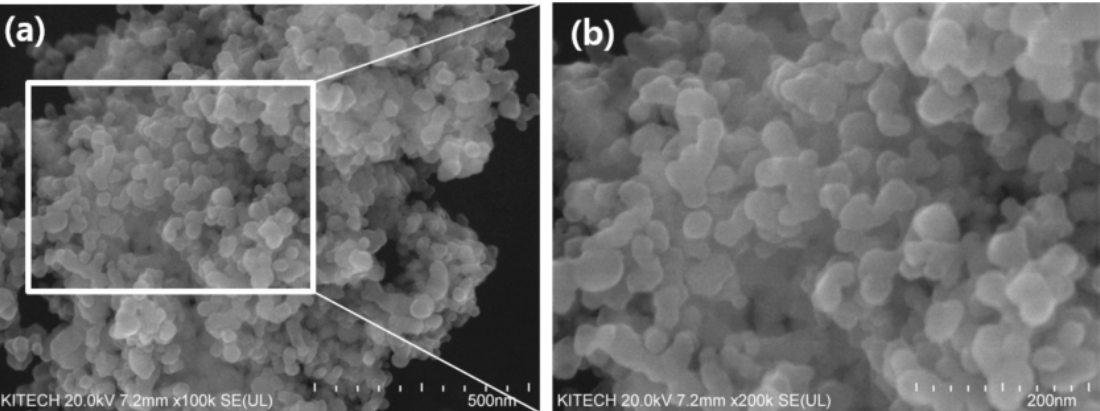
Figure 1. The morphology of ( a ) the synthesized TiO 2 nanoparticles ( b ) the enlarged image of the square on the left